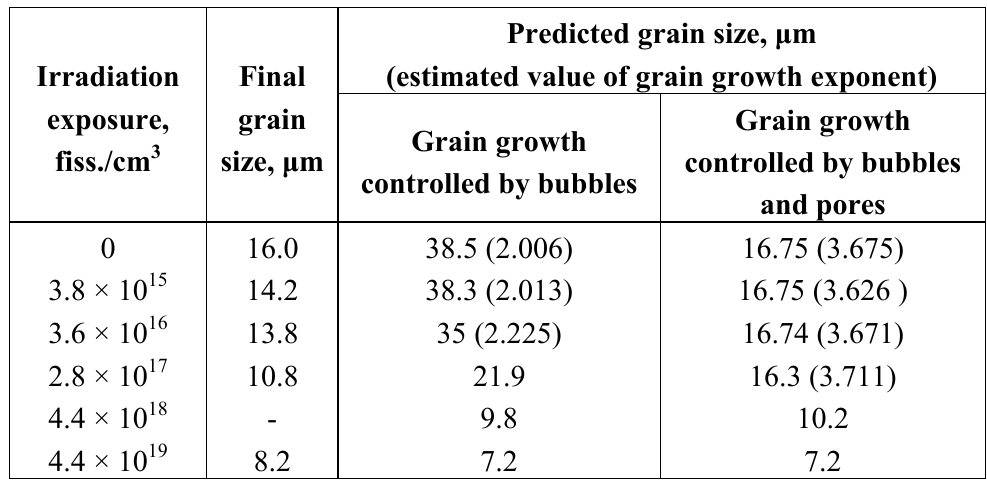
Table 1. Simulation of the MacEwan and Hayashi